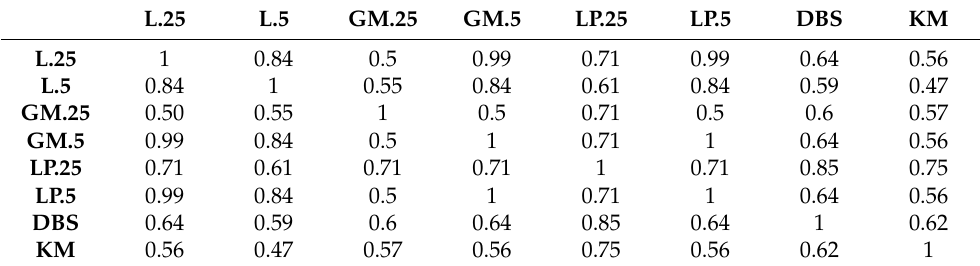
Table 8. FMI index for wholesale customers clustering.